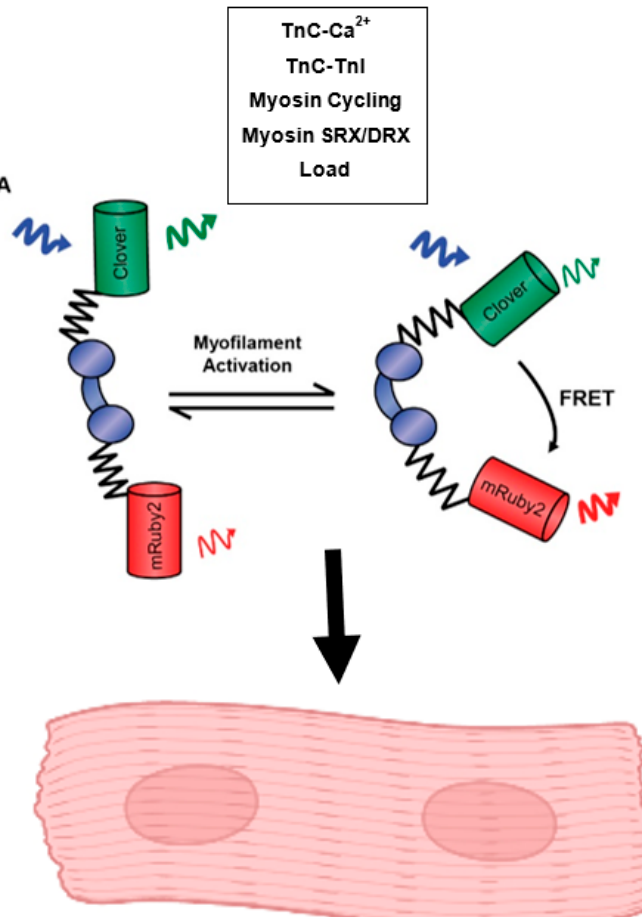
Figure 3. Function of the Cardiac-Expressed Sarcometer. This model illustrates the construction of the cardiac TnC biosensor which functions through changes in FRET fluorescence driven by the conformational changes TnC undergoes in response to calcium binding, TnC-TnI interactions, myosin cycling, the activation states of myosin, and changes in load. This biosensor has been expressed in a stable transgenic mouse line and can be used to study sarcomere activation in isolated, intact cardiac myocytes and intact cardiac papillary